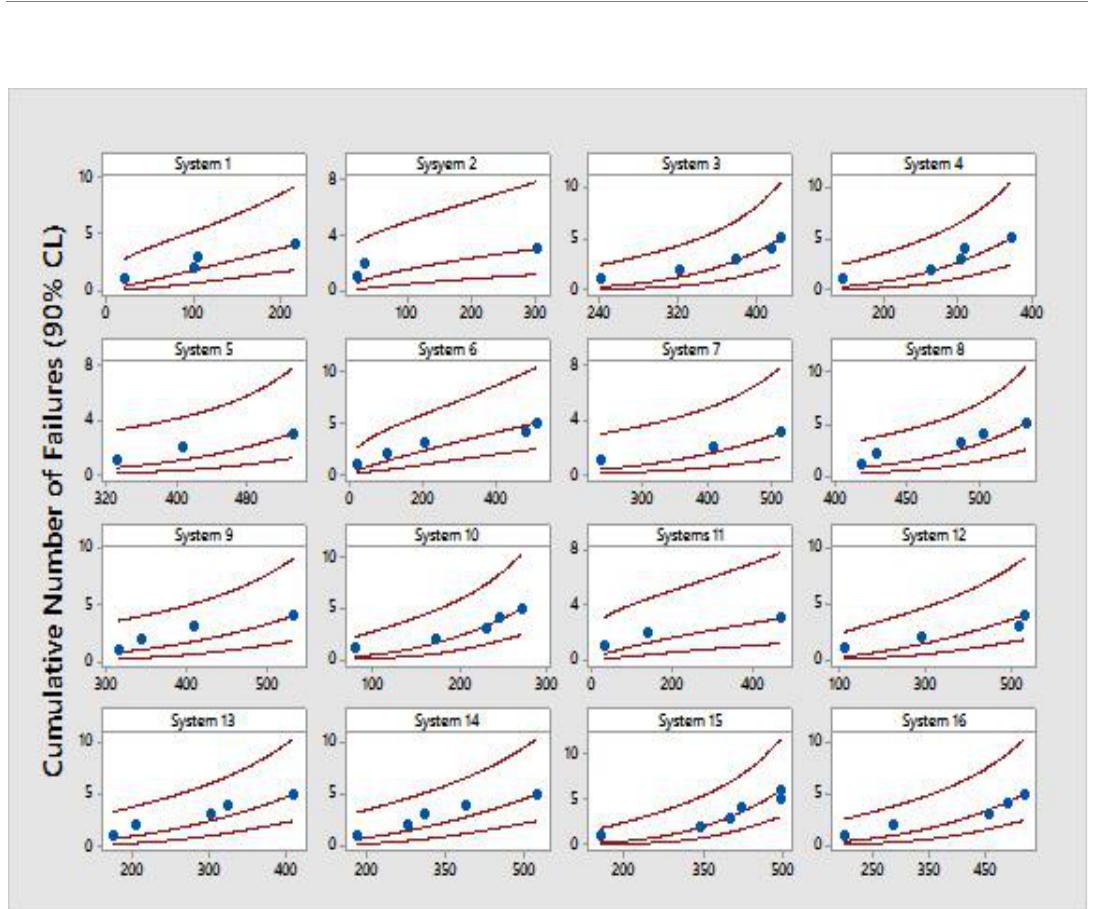
Figure 5. Cumulative number of failures plots for each